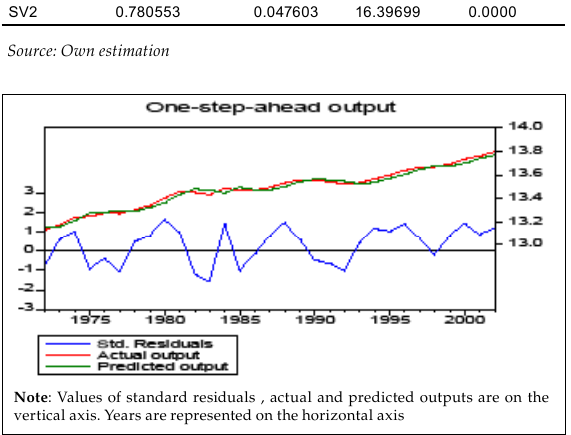
figure 1 Dynamic fit of the production function (Source: Own